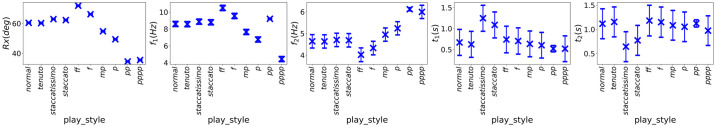
The final predictions, after 3125 learning epochs, of the required control parameters for 10 different playing styles.The Confidence intervals are shown as normalized predictive variance, and show the predictive uncertainty of the GP model.